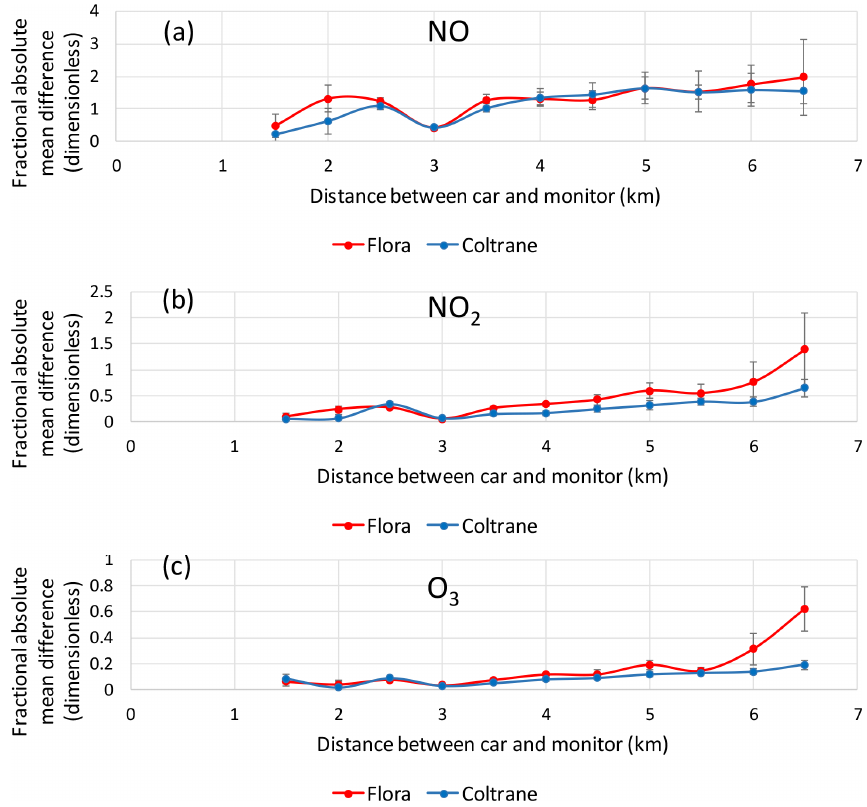
Figure 4. Fractional absolute mean difference (FAMD) for (a) NO, (b) NO 2 , and (c) O 3 vs mean intervehicle distance for 3–12 August 2016, Los Angeles sampling, averaged over 0.5km bins. Error bars are 1 σ uncertainties as described in the text. The sizes of the error bars reflect variations in the number of samples in each bin ( N = 3–19 at 6.5km to 222–338 at 3.5km). The 3km bin ( N = 1273–3906) consists primarily of measurements made in the parking